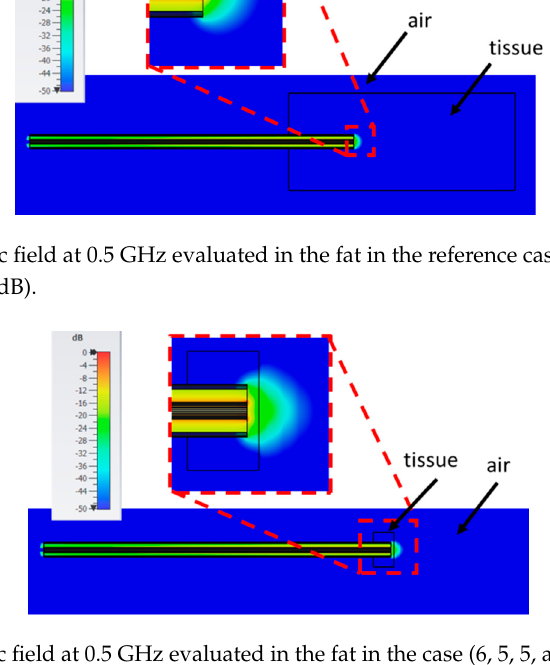
Figure 12. RMS electric field at 0.5 GHz evaluated in the fat in the case (6, 5, 5, a), i.e., the case in which the maximum average error was calculated (Table 3). Colour scale in dB max (0; − 50 dB).